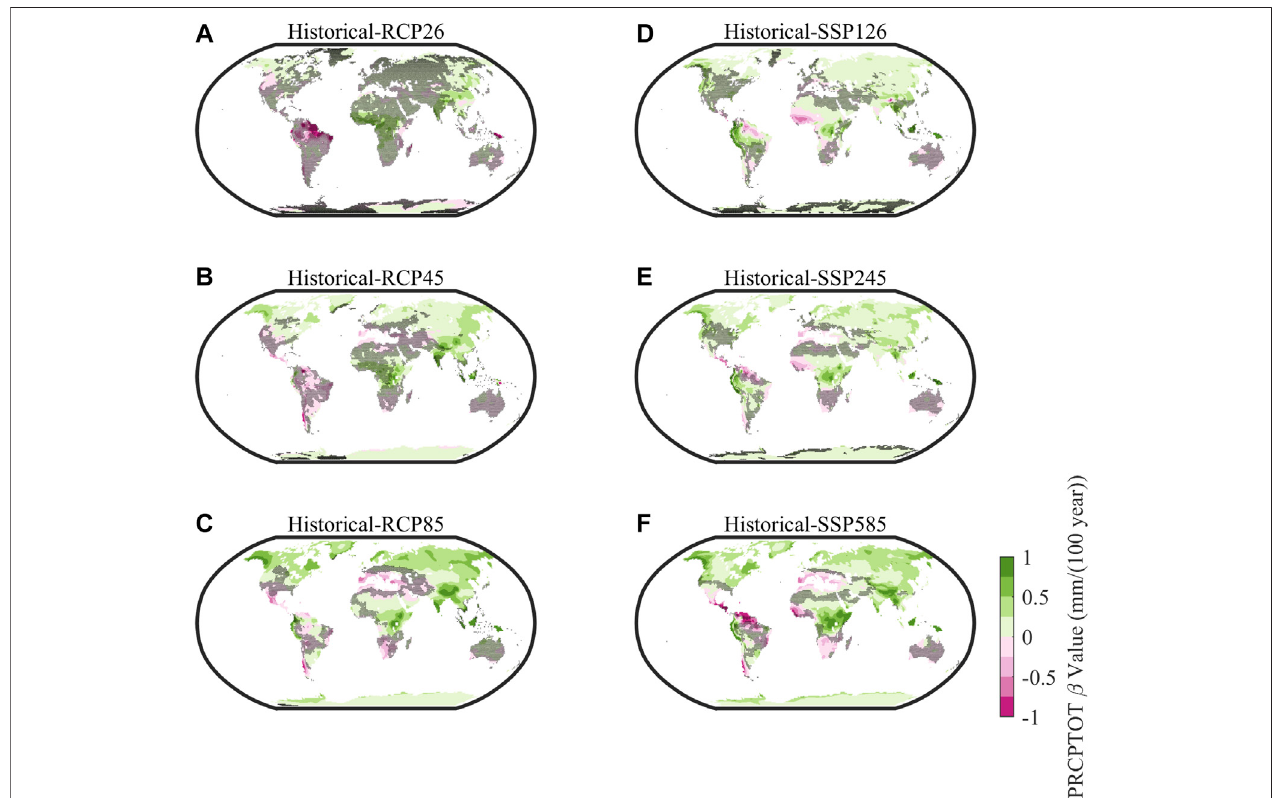
FIGURE 4 | The spatial distributions of the Sen ’ s slope estimator test ( β ) for multi-model mean PRCPTOT. It shows β values of the long series precipitation (1982 – 2100) under different future scenarios in CMIP5 (A – C) and CMIP6 (D – F) . The points represent non-signi fi cant trend at the 99% con fi dence level based on the MK